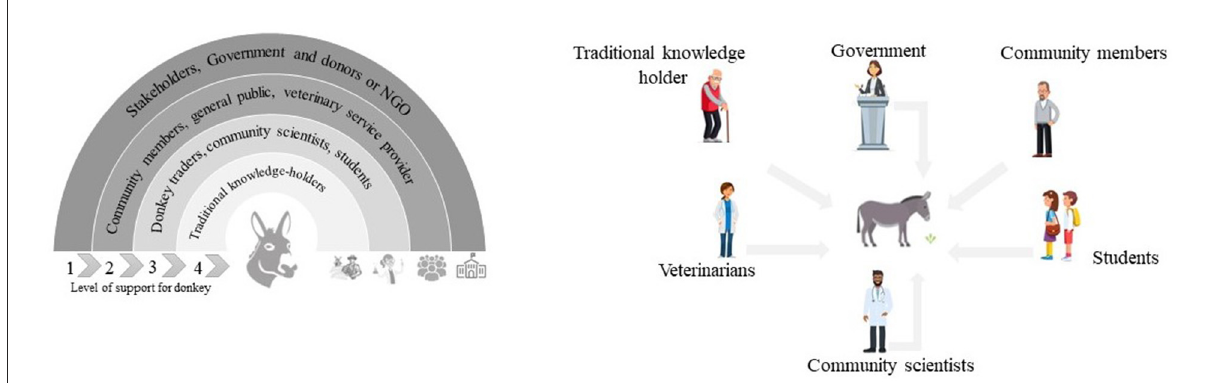
FIGURE5 Conceptual models of various characters and working groups for healthcare management and welfare of donkeys. Left: Donkey assisted by collaborating in the practice model shows work overlapping of different communities. The center of the diagram depicts the donkey - the circle begins with the leading role of the government and NGOs in donkey welfare (such as providing legal assistance to improve donkey carriers and chart equipment, adjusting the price for the sale of the individual donkey, traffic police guidelines to run the donkey carts along with